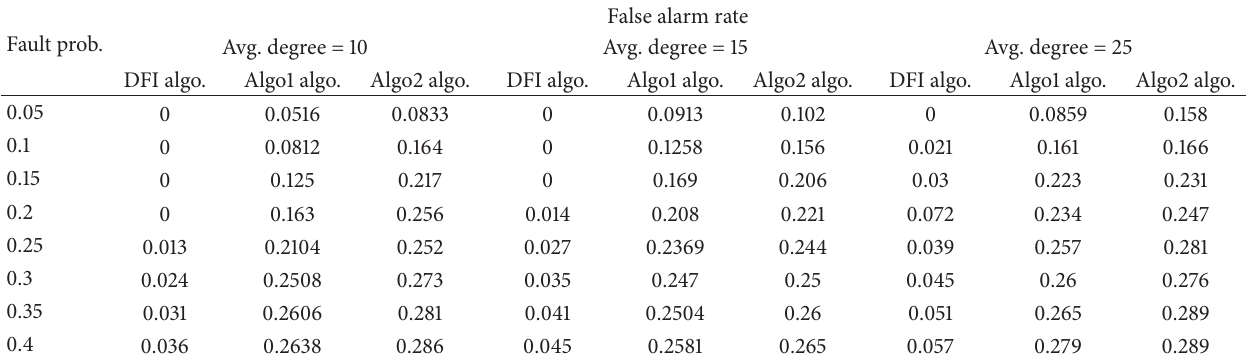
Table 4: Comparison of FAR for different algorithms.